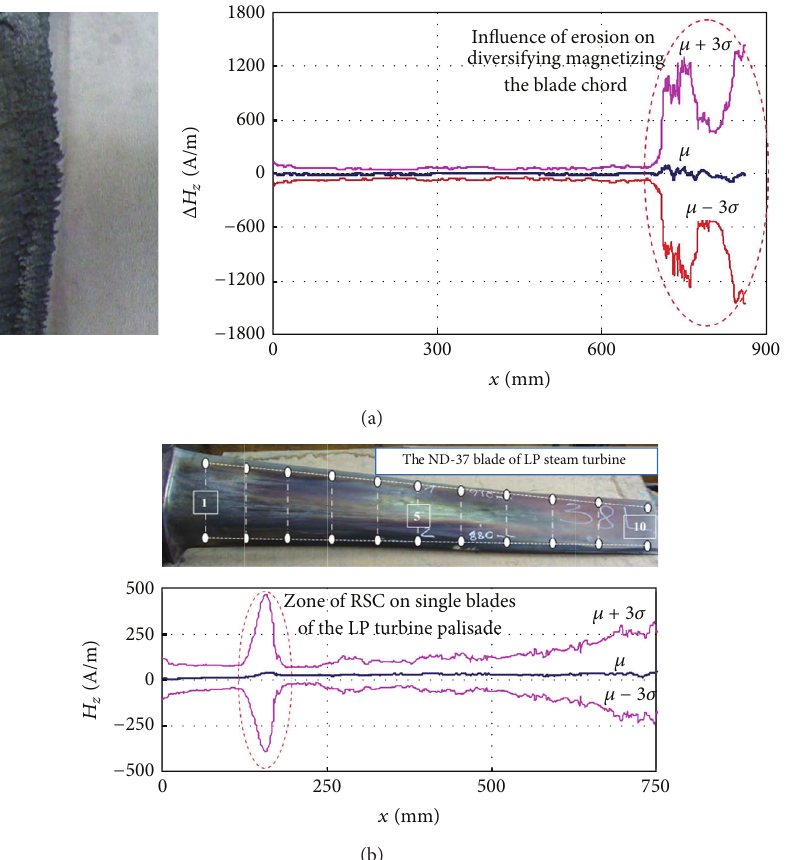
Figure 23: Early detection of the hidden fatigue risk (blade overload and diversifying the income of erosion) on the example of the ND37 blades of the steam turbine